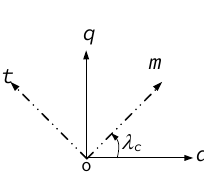
Figure 2. Relationships between the CM synchronous reference frame and the rotor reference frame.